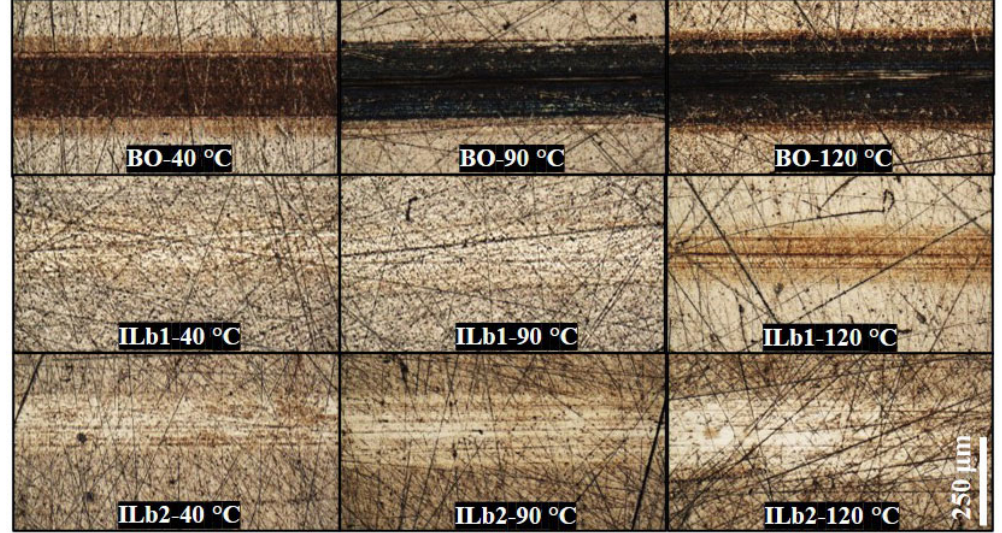
Fig. 4 Optical images of the wear tracks from sliding friction tests conducted for BO, ILb1, and ILb2 at 40, 90, and 120